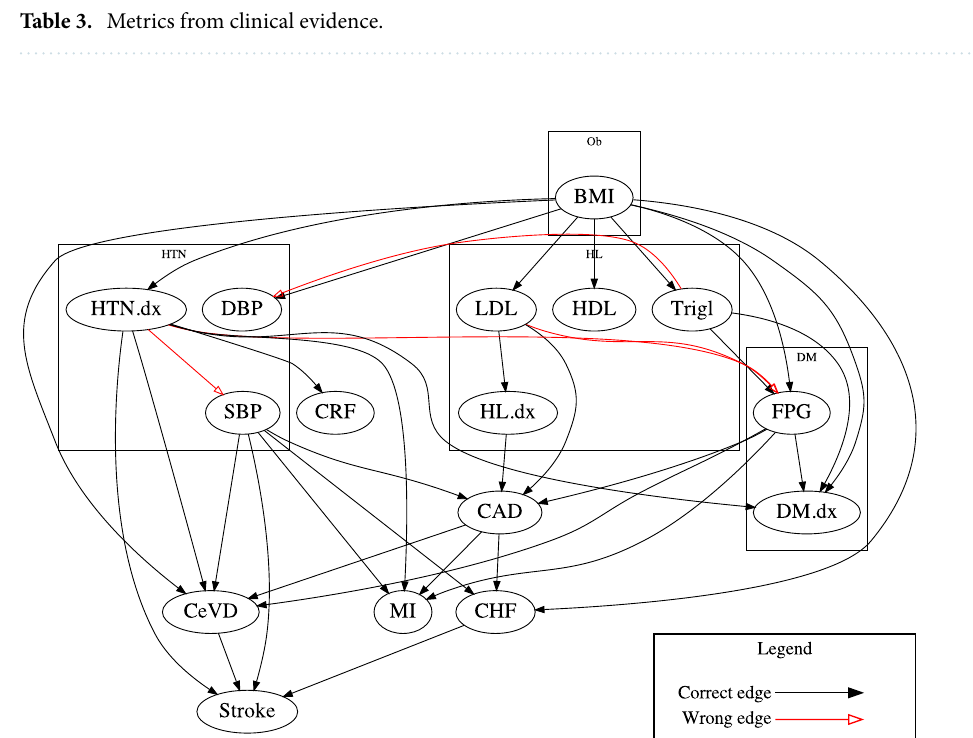
Figure 2. Causal graph discovered by the proposed method. The ‘.dx’ suffix indicates diagnosis of the disease. The abbreviations of the diseases and lab results can be found in Table 1.